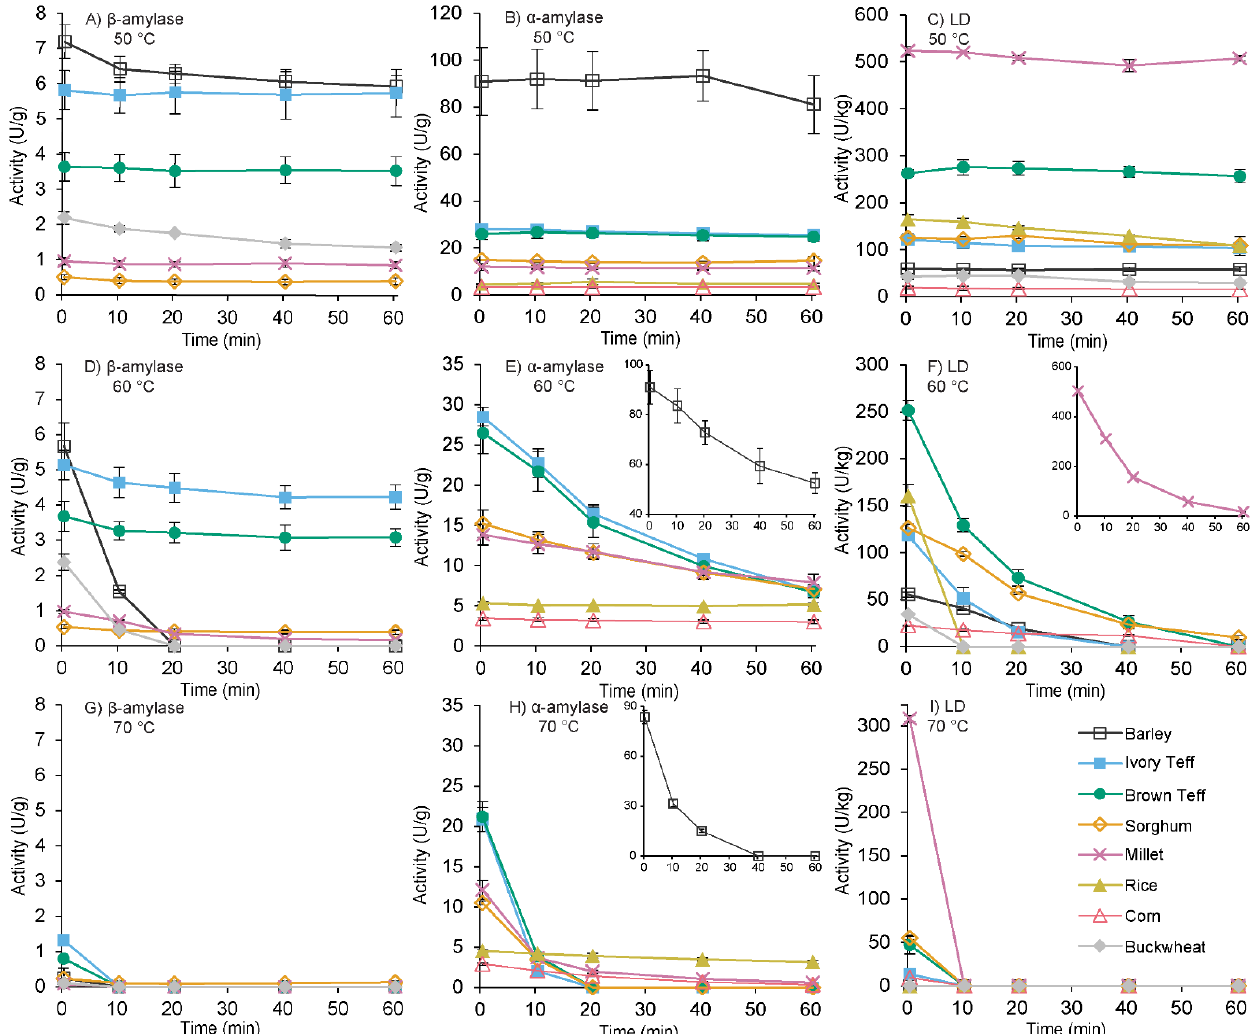
Figure 2. The measured thermostability of the mashing enzymes, expressed as the amount of activity measured after incubation at 0, 10, 20, 40, and 60 min at 50, 60, and 70 °C. Time 0 min is designated after a 2 min come-up time to equilibrate the extracts to the selected incubation temperature. At 70 °C, in particular, this 2 min equilibration led to significant loss of activity across most enzymes. β -amylase ( A , D , G ) α -amylase ( B , E , H ), and LD ( C , F , I ) activities were determined using the method described in Section 2.8. Insets in E and H are barley α -amylase plotted individually to better show the deactivation of the GF malts’ α -amylase, and the thermostability of rice and corn α -amylase. The inset in F is the inactivation curve of millet LD at 60 °C in order to better show the denaturation of LD in the remaining malts. Data represent the means ( n = 3) ± standard deviation, and some error bars are within data points.